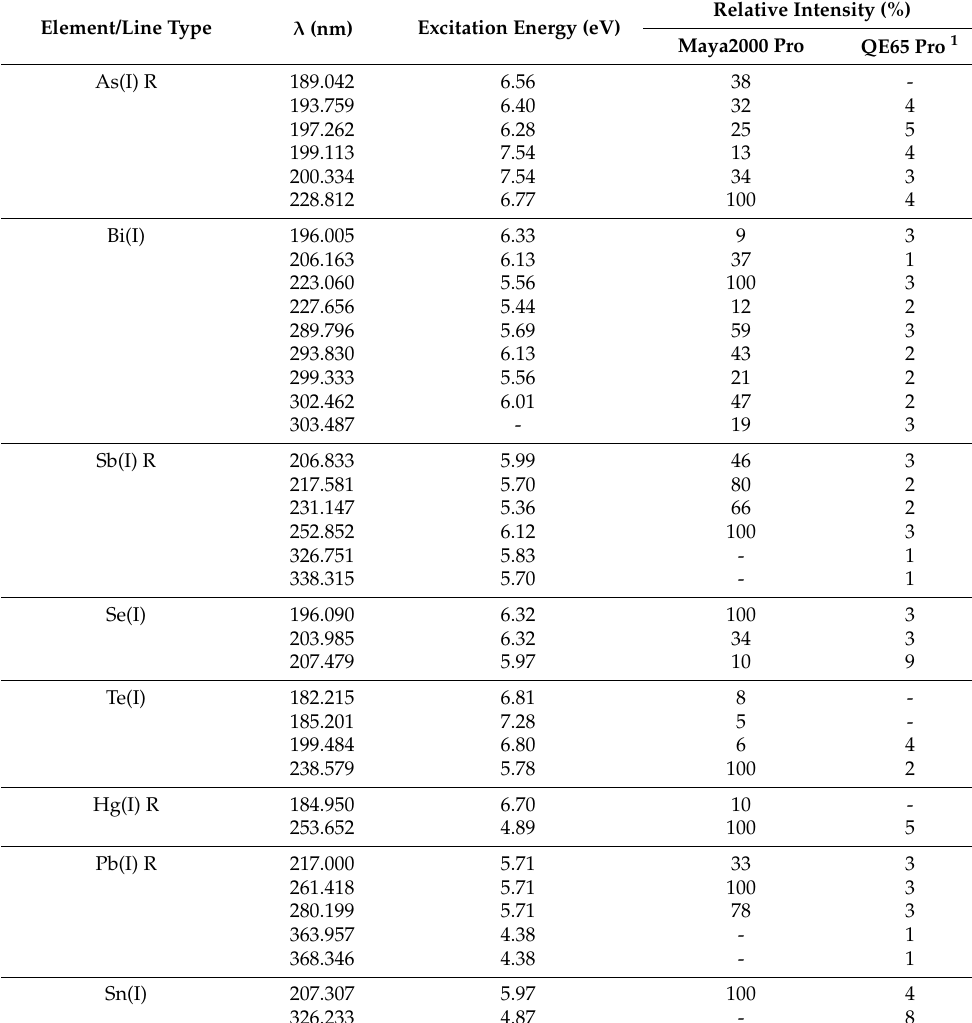
Table 1. Characteristics of the lines identified in the emission spectrum recorded with Maya2000 Pro and QE65 Pro